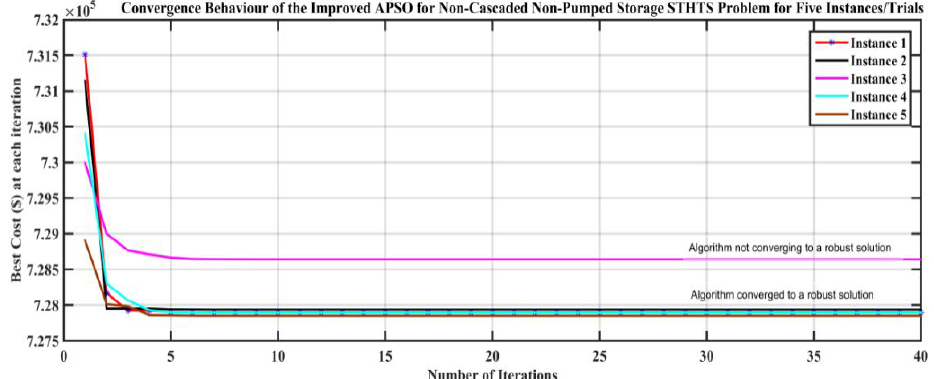
Figure 8. Convergence characteristics of the improved APSO algorithm on the non-cascaded non-pumped STHTS problem for five different